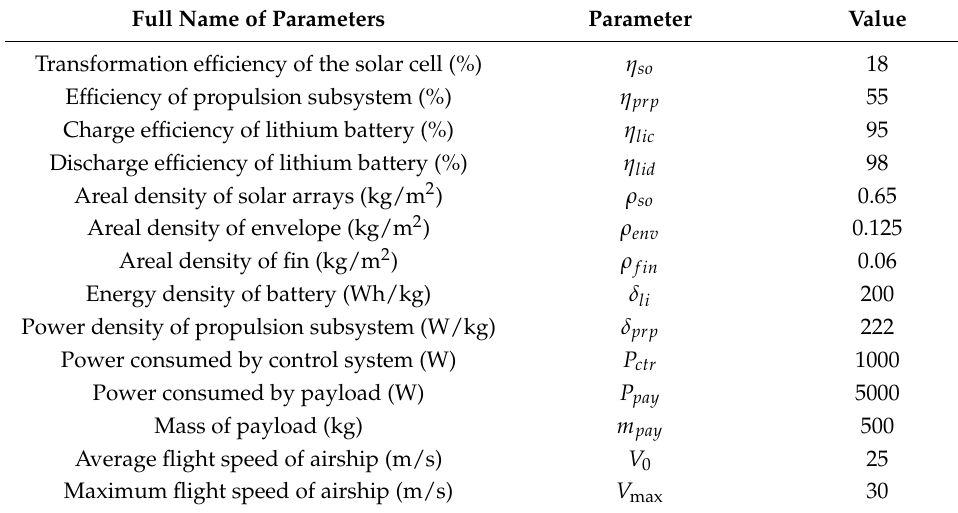
Table 2. Parameter values used for the airship problem.